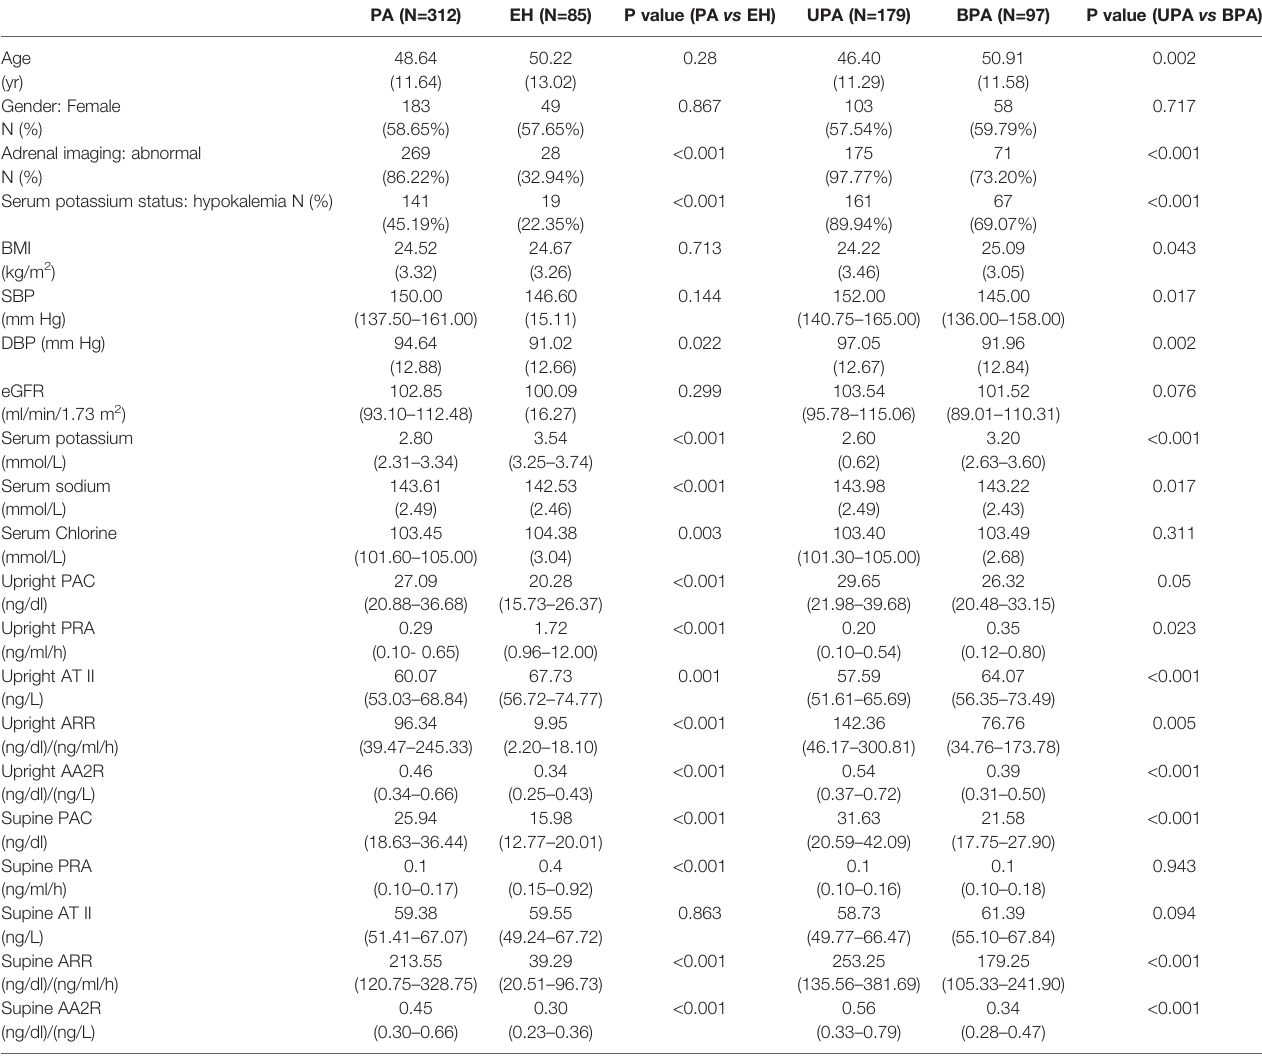
TABLE 1 | Comparison of baseline data between groups (PA vs EH and UPA vs